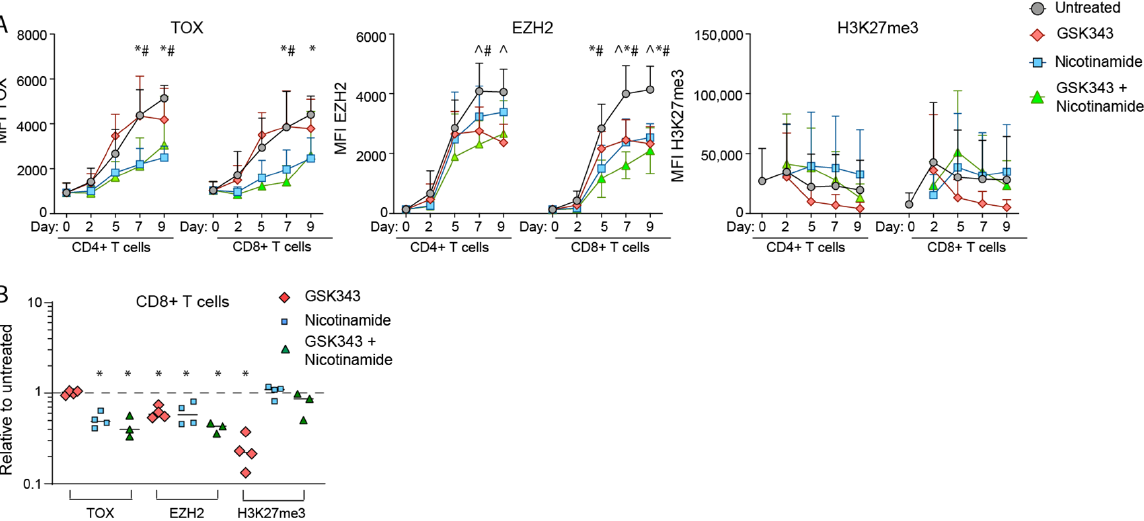
Figure 3. Expression pattern of TOX, EZH2 and H3K27me3 in the presence of NAM and EZH2i. ( A ) Time course shown for average across four experiments, with error bars indicating standard deviation, and statistical significance between treated conditions and untreated indicated by ^ for GSK343, * for nicotinamide and # for GSK343 + nicotinamide, as determined using the Holm-Sidak method ( α = 0.05). Additional statistics performed on ( B ) combined data when compared to untreated only for day seven across n = 4 in vitro stimulation experiments ( p < 0.05 indicated by *). Mean fluorescent intensity (MFI) were calculated for each time